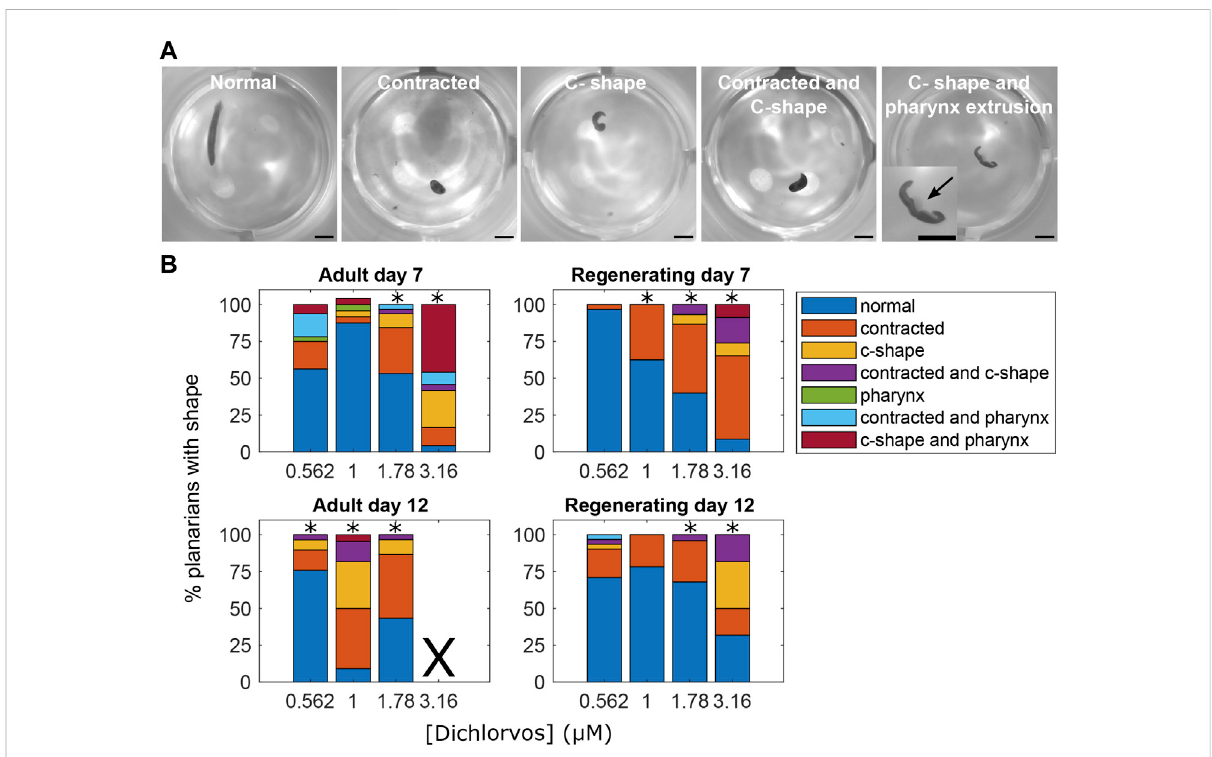
FIGURE 3 Abnormal body shapes induced by OP exposure. (A) Examples images of normal and abnormal body shapes observed in the OP-treated planarians.Thenormalplanarianisfromthevehiclecontrols.Thecontractedplanarianwastreatedwith316 µMmalathion.Theremainingimagesare of dichlorvos-treated planarians. Scale bar: 1 mm. Inset shows magni fi ed image of the planarian with the arrow pointing to the pharynx which is extruded from the body. (B) Stacked bar plot showing the percentage of planarians exhibiting the different body shape categories as a function of dichlorvos concentration in µM. Concentrations which are above the BMC for the outcome measure are marked with *. Xindicates 100% lethality at 3.16 µM dichlorvos in adult planarians on day